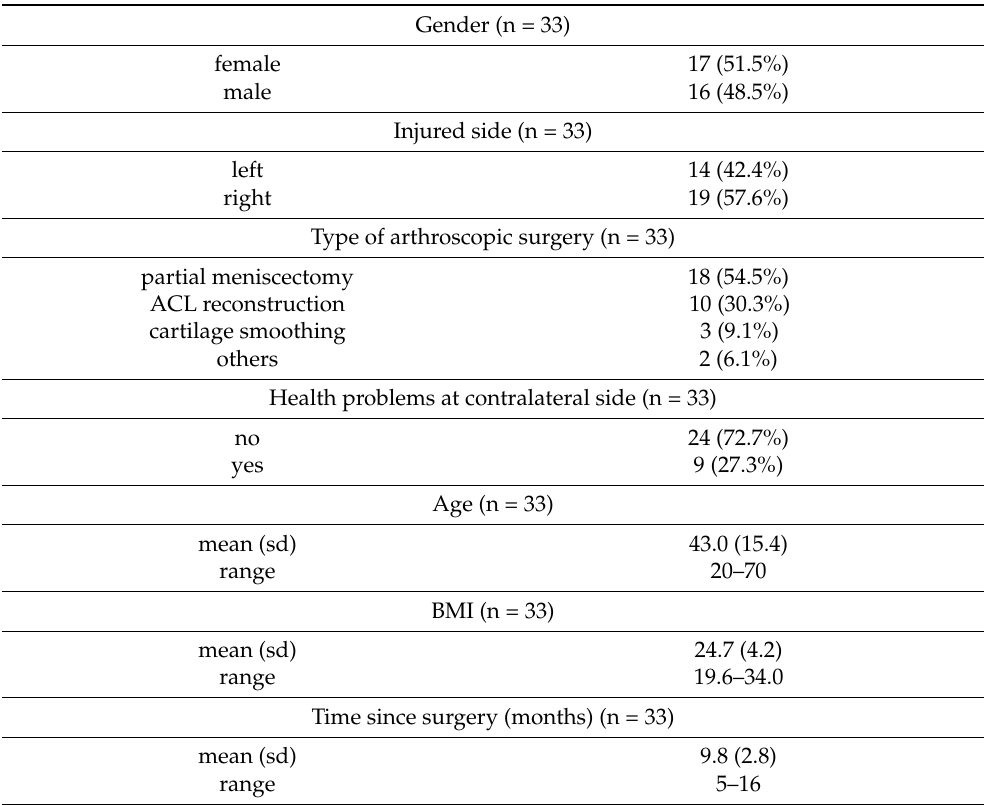
Table 3. Patient